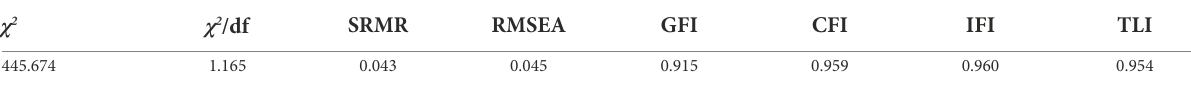
TABLE 6 Fitness